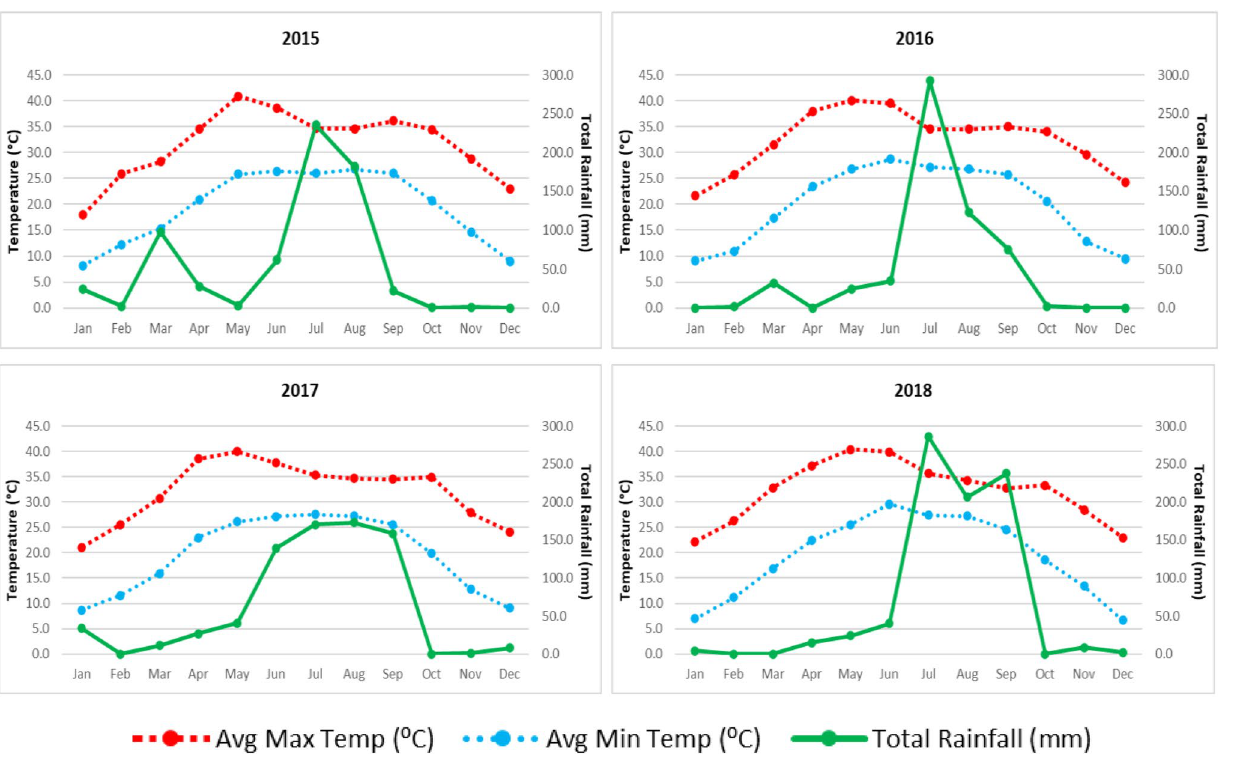
Figure 1. Line Graph showing the month-wise pattern of environmental variables in the year 2015–2018 in Delhi.